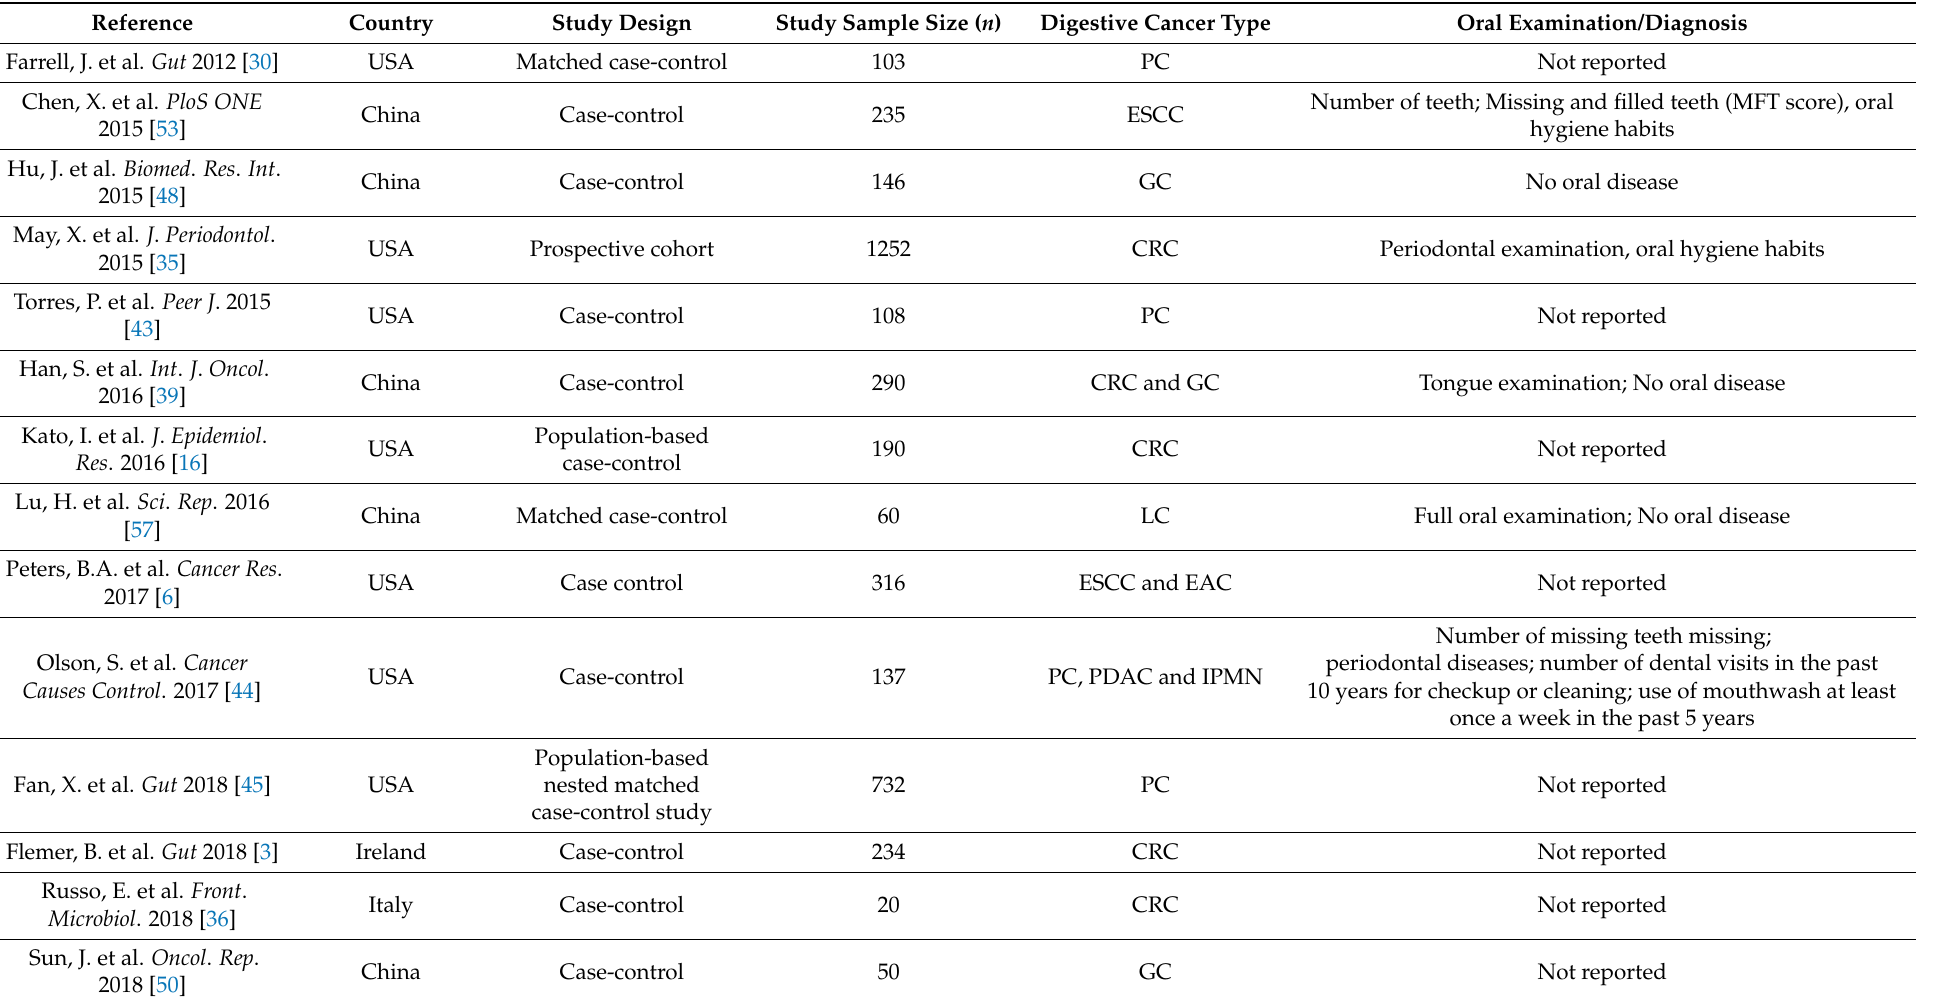
Table 1. General characteristics of the selected studies investigating the association between oral microbiota and digestive